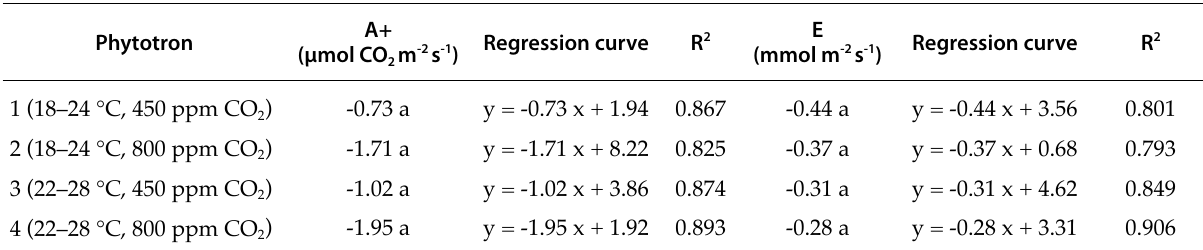
Table 6. Linear regression analyses of assimilation (A) and transpiration rate (E) for zucchini plants grown in different temperature and CO 2 regimes.